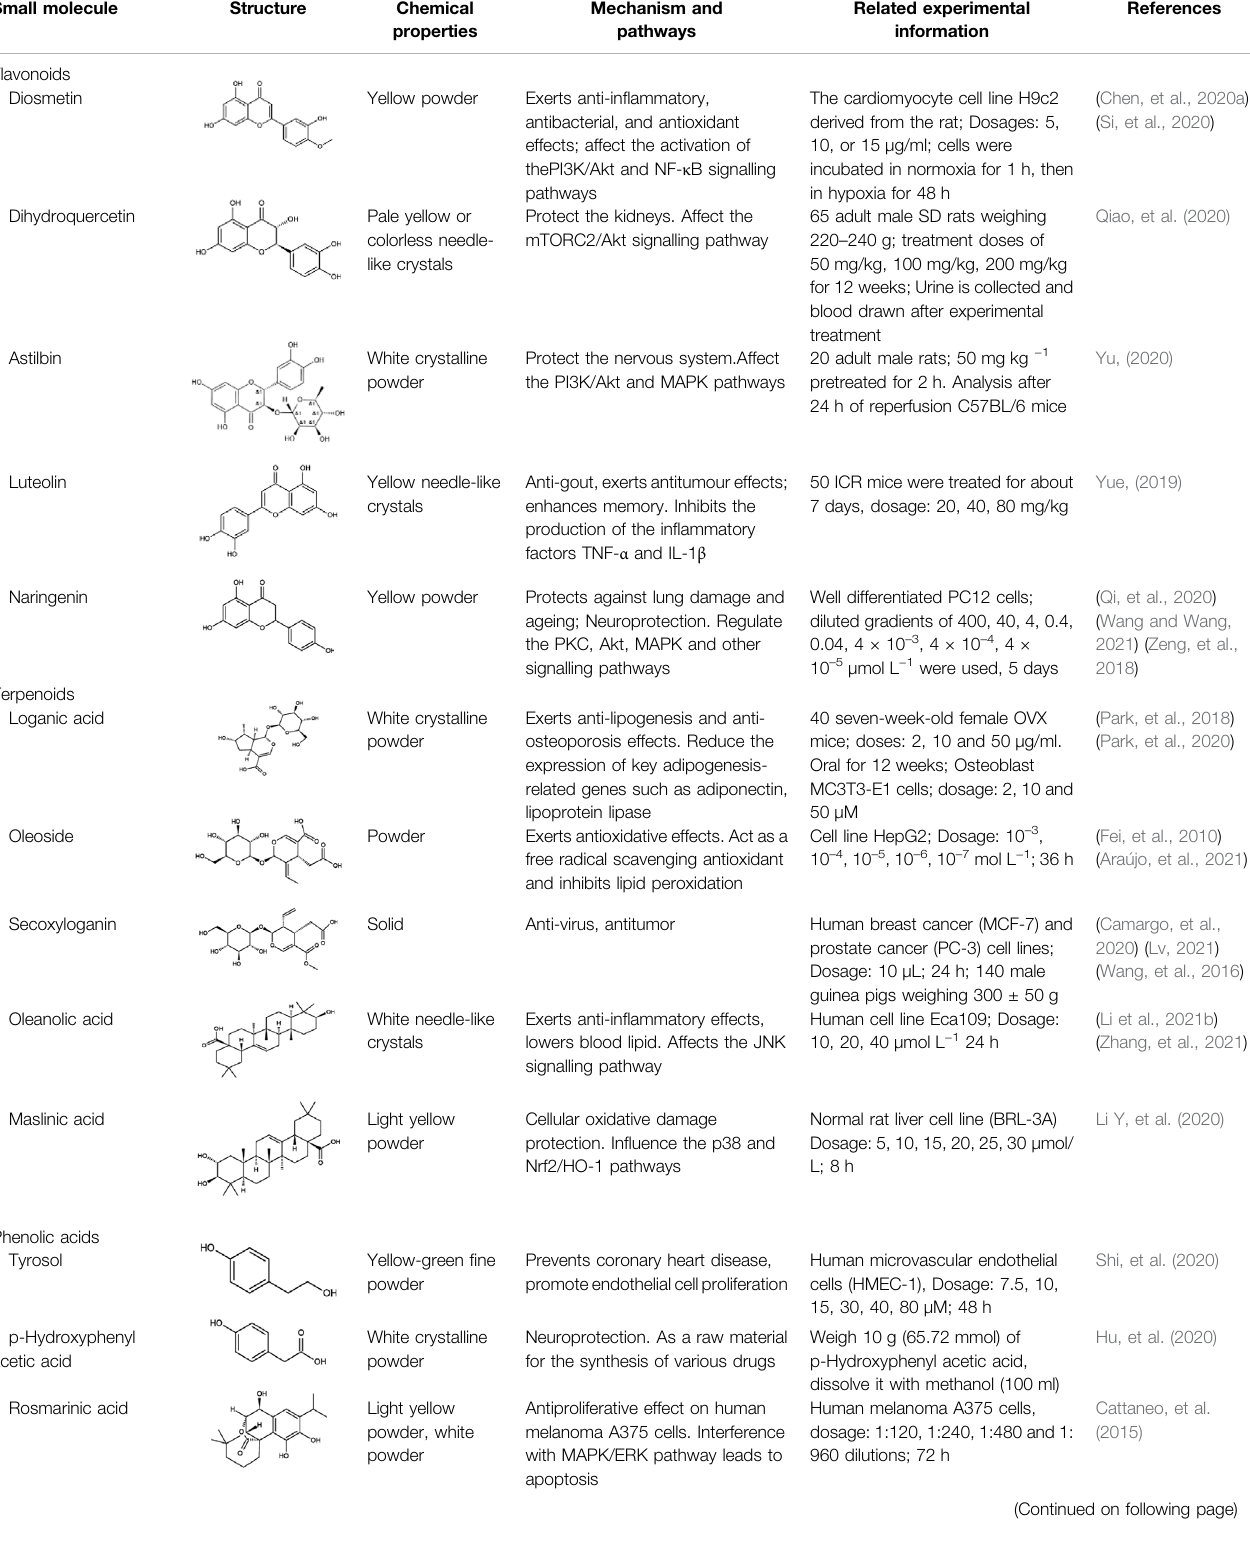
TABLE 1 | Fifteen major secondary metabolites in O. fragrans